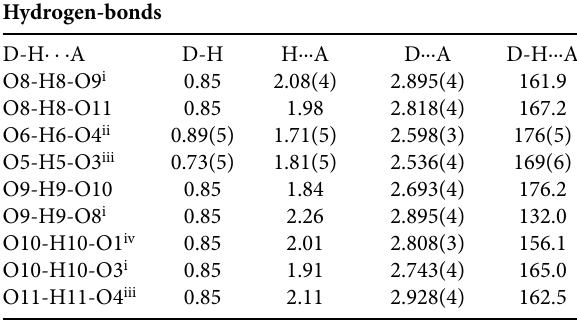
Figure 3. ((a) 2-D supramolecular network along the [010] direc- tion in [Cd(IsoPht)(TEA)H 2 O]·3H 2 O complex. (b) π···π interaction